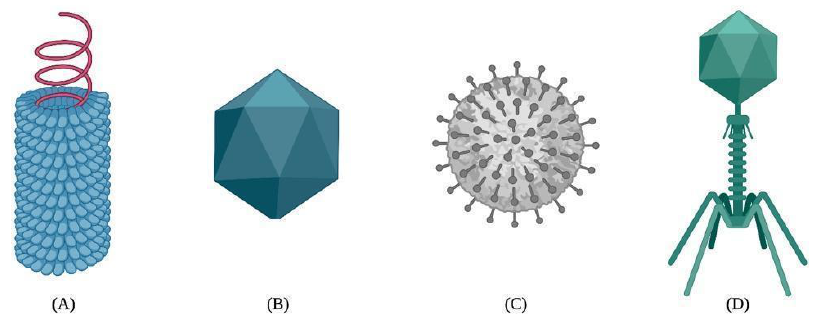
Figure 1. Different types of viral capsids: ( A ) helical, ( B ) icosahedral, ( C ) spherical, and ( D )